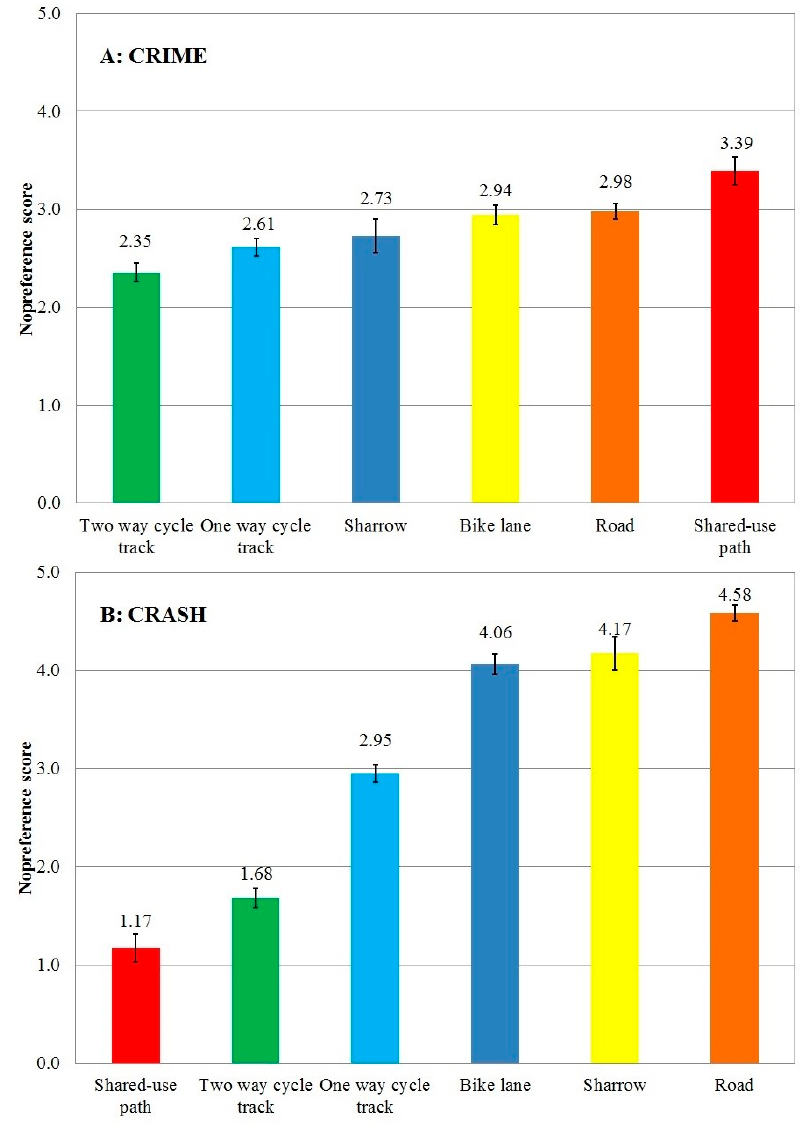
Figure 2. Adjusted mean scores (95% confidence intervals) for perception of crime and crash risks for the 6 bicycle facility types. Adjusted for age, sex, whether they know how to bicycle, and street sense or community sense using general linear regression models. Tukey’s multiple comparisons tests were used to compare the differences between each two groups.